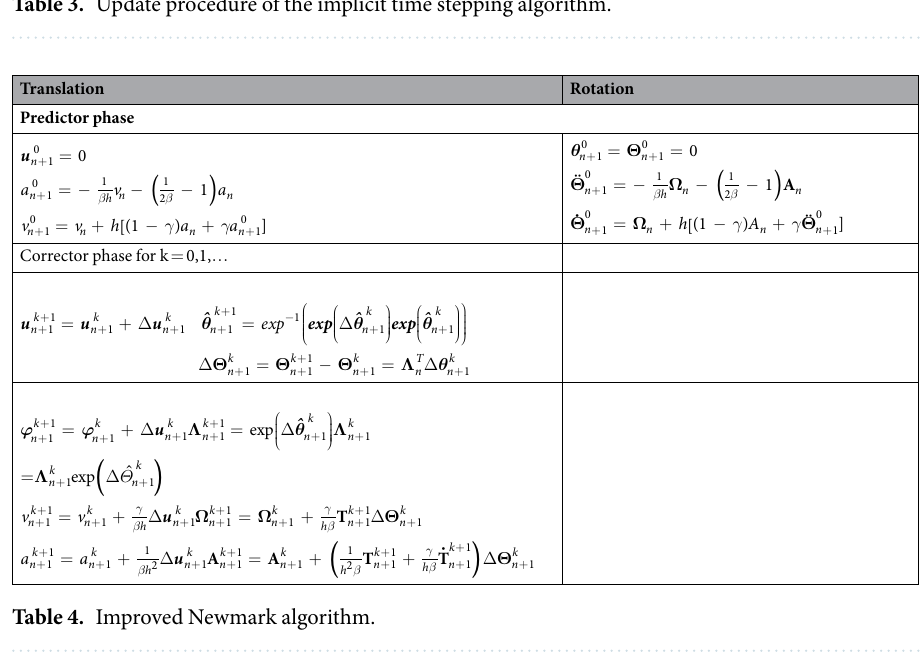
Table 3. Update procedure of the implicit time stepping algorithm.